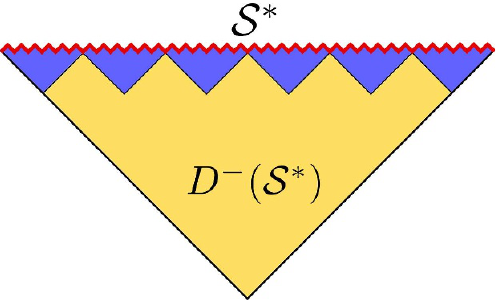
Figure 8 . When the bulk volume remains sufficiently bounded in the vicinity of the terminal surface, the local complexity of S ∗ results from the limit of an extreme coarse graining.